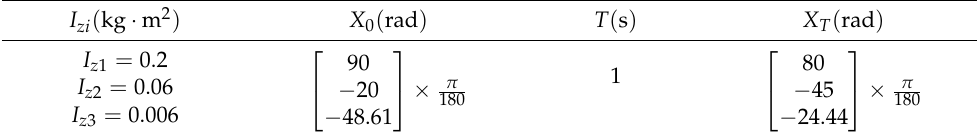
Figure 8. Initial state (solid line) and end state (dashed) for under-constrained cable-driven robot in trajectory planning. Table 5. Parameters about Figure 8 to link rotational inertia and trajectory